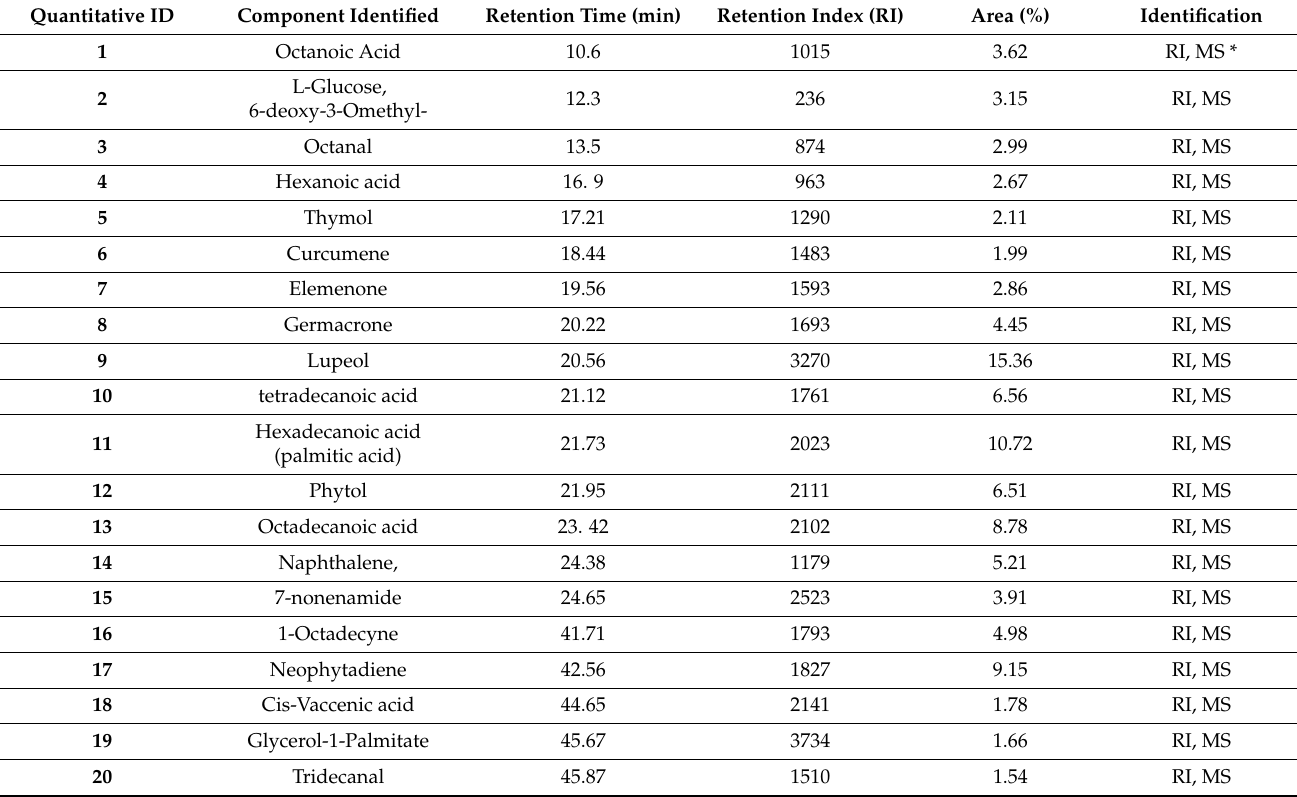
Table 1. The list of main constituents present in C. acutum latex using GC-MS